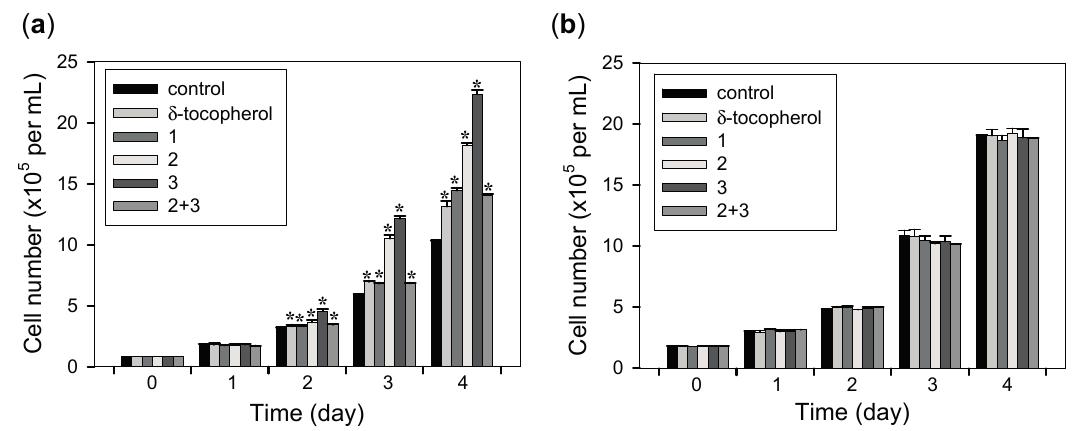
Figure 5. Cell proliferation activities of δ -tocopherol, all isolates , or the mixture of 2 and 3 ( a ) on NIH3T3 cells and ( b ) on HeLa cells. Equal numbers of cells were treated with DMSO alone (control), 10 µM of δ -tocopherol, all isolates, or the mixture of 2 and 3 ( 2 + 3 ) and cells were counted every 24 h. Data represent the mean ± s.d. of three independent experiments. * p < 0.05 vs. control (DMSO alone).